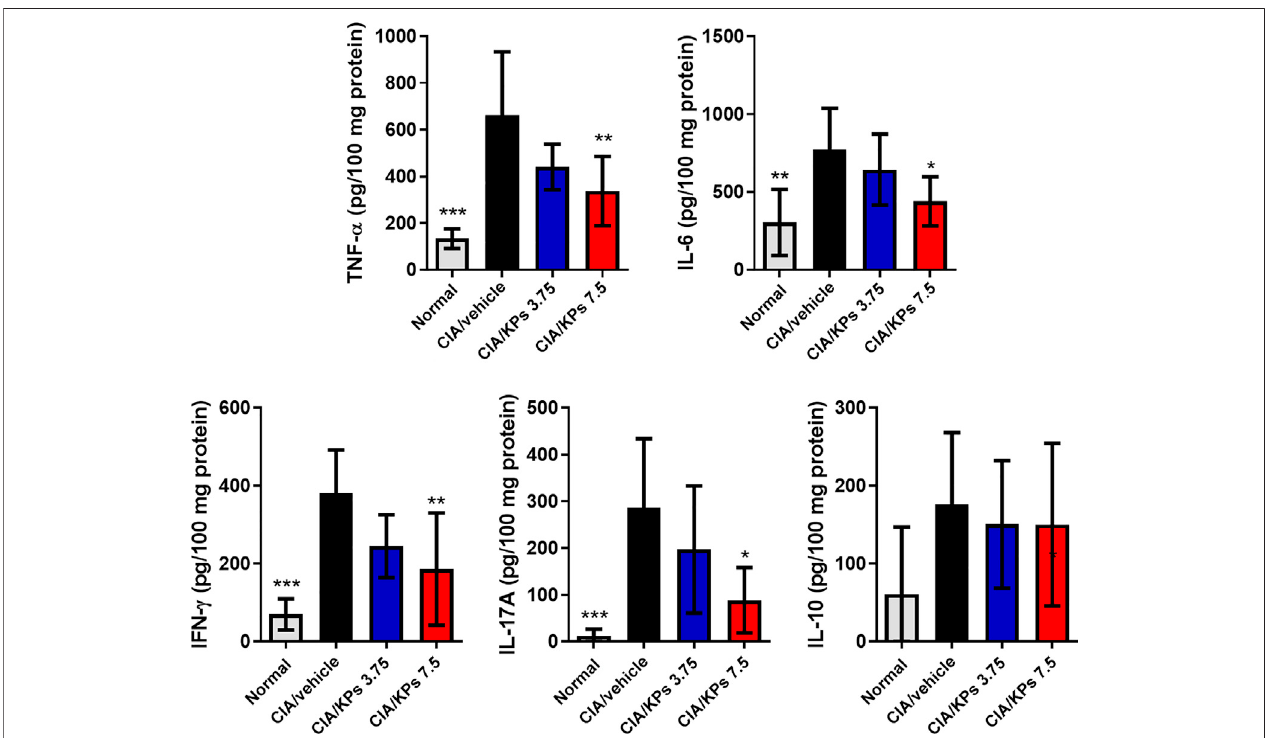
FIGURE 4 | Effects of KPs on proin fl ammtory cytokine expression in the paws of CIA mice. The paw tissue homogenates were obtained on day 42. The cytokines TNF- α ,IL-6,IFN- γ ,IL-17A,andIL-10weremeasured byELISA.Thedataarepresentedasthemean ± SEM(n (cid:1) 5).* p < 0.05;** p < 0.01;*** p < 0.001vstheCIA/vehicle control group, as determined by one-way ANOVA with Dunnett ’ s